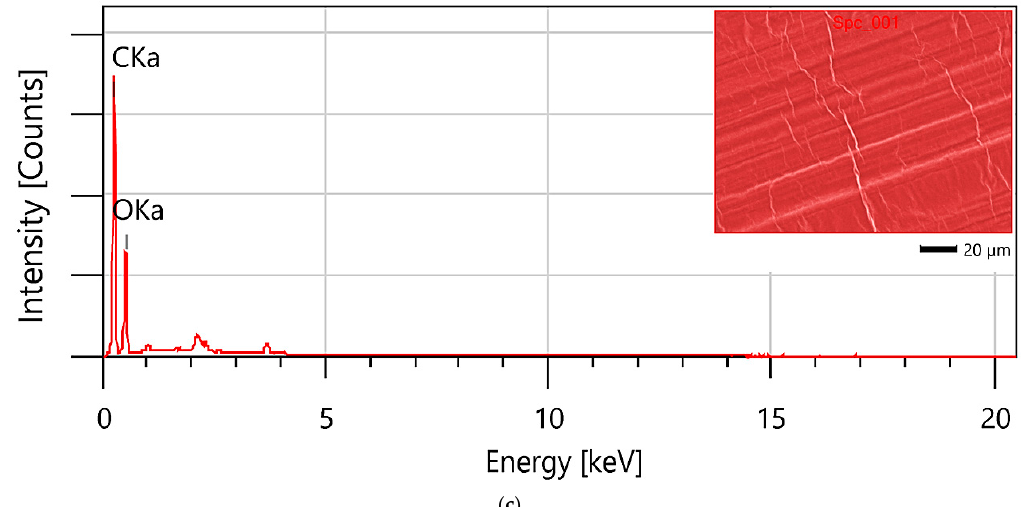
Figure 2. Analyses of GO: ( a ) SEM image; ( b ) AFM image; ( c ) elemental composition (EDX). SEM examination showed that the studied ZrS 3 nanocrystals after ultrasonic treat- ment were more than 10 μ m in length and 0.4–3 μ m in width (Figure 3a). AFM showed that the average thickness of the crystals was 50–120 nm (Figure 3b). The composition of the material included zirconium and sulfur (Figure 3c).